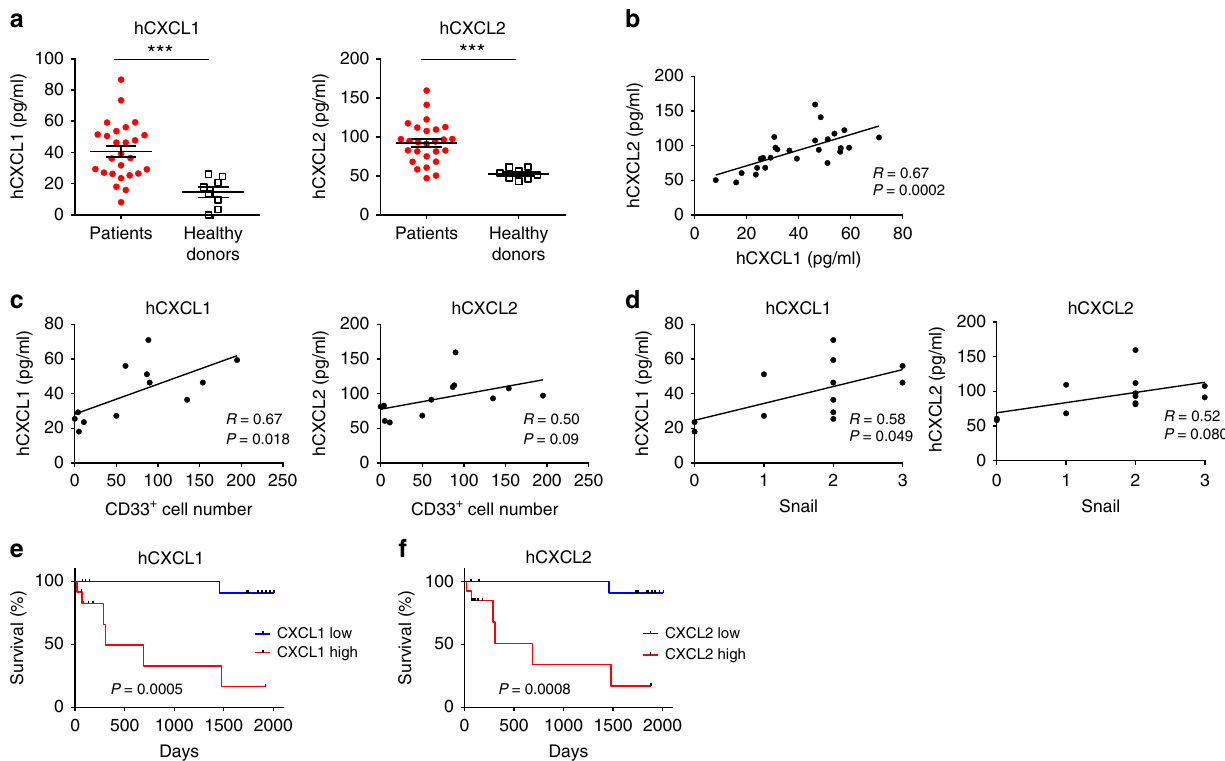
Fig. 8 Elevated levels of serum CXCL1 and CXCL2 re fl ect intratumoral MDSCs and are associated with poor prognosis in ovarian cancer patients. a Serum concentration of CXCL1 (left) and CXCL2 (right) in ovarian cancer patients ( n = 26) vs. that in healthy donors ( n = 8); mean ± SEM; *** P < 0.001 by unpaired t -test. b Correlation between CXCL1 and CXCL2 serum concentrations in ovarian cancer patients ( n = 26); P = 0.0002, R = 0.67. Pearson ’ s product-moment correlation analysis. c Correlation between serum CXCL1 (left; P = 0.018) and CXCL2 (right; P = 0.09) levels and in fi ltration of CD33 + cells in peritoneal disseminations; n = 12; Pearson ’ s product-moment correlation analysis. d Correlation between serum CXCL1 (left; P = 0.049) and CXCL2 (right; P = 0.080) levels and Snail staining scores; n = 12; Pearson ’ s product-moment correlation analysis. e Overall survival of ovarian cancer patients, comparing the high-serum CXCL1 group ( n = 12) to the low-serum CXCL1 group ( n = 14). Cut-off levels, 42.83 pg/ml; AUC = 0.6842. Hazard ratio, 15.08; 95% con fi dence interval (CI), 3.859 – 102.9; P = 0.0005 by log-rank test. f Overall survival of ovarian cancer patients, comparing the high- serum CXCL2 group ( n = 13) to the low-serum CXCL2 group ( n = 13). Cut-off levels, 93.57 pg/ml; AUC = 0.6767. Hazard ratio, 13.87; 95% con fi dence interval (CI), 3.56 – 89.72; P = 0.0008 by log-rank